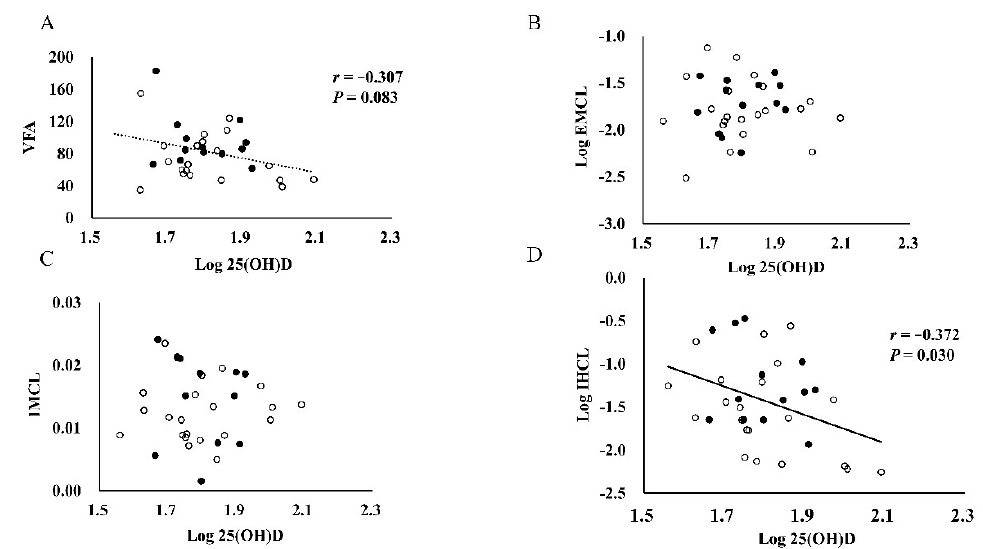
Figure 2. Associations among serum 25(OH)D with VFA ( A ), EMCL ( B ), IMCL ( C ), and IHCL ( D ). 25(OH)D, 25-hydroxyvitamin D; VFA, visceral fat area; IMCL, intramyocellular lipid; EMCL, extramyocellular lipid; IHCL, intrahepatic lipid. Closed and open circles represent data from American footballers and rugby footballers, respectively.